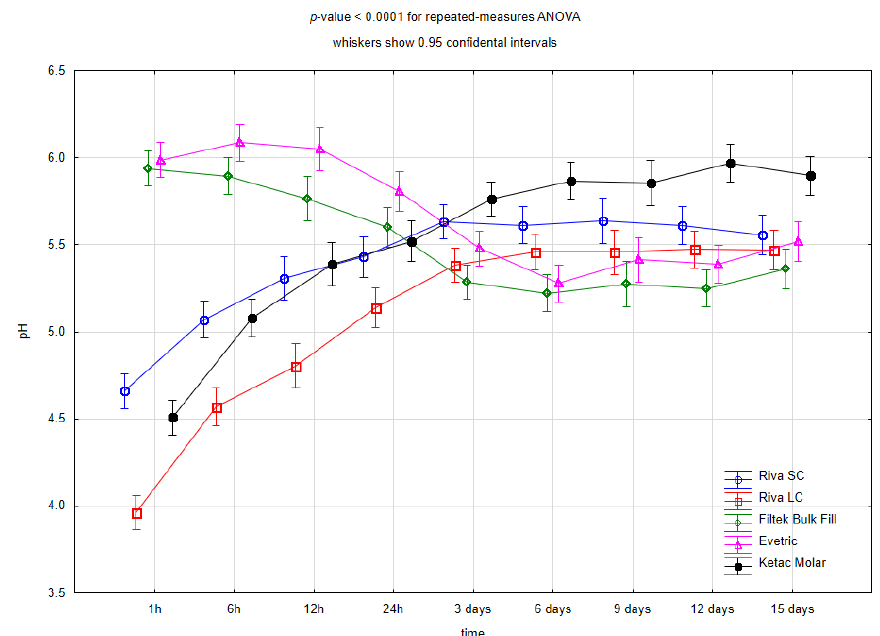
Figure 2. Repeated-measures analysis of variance for pH values in the individual time points depending on the dental restorative material for the one